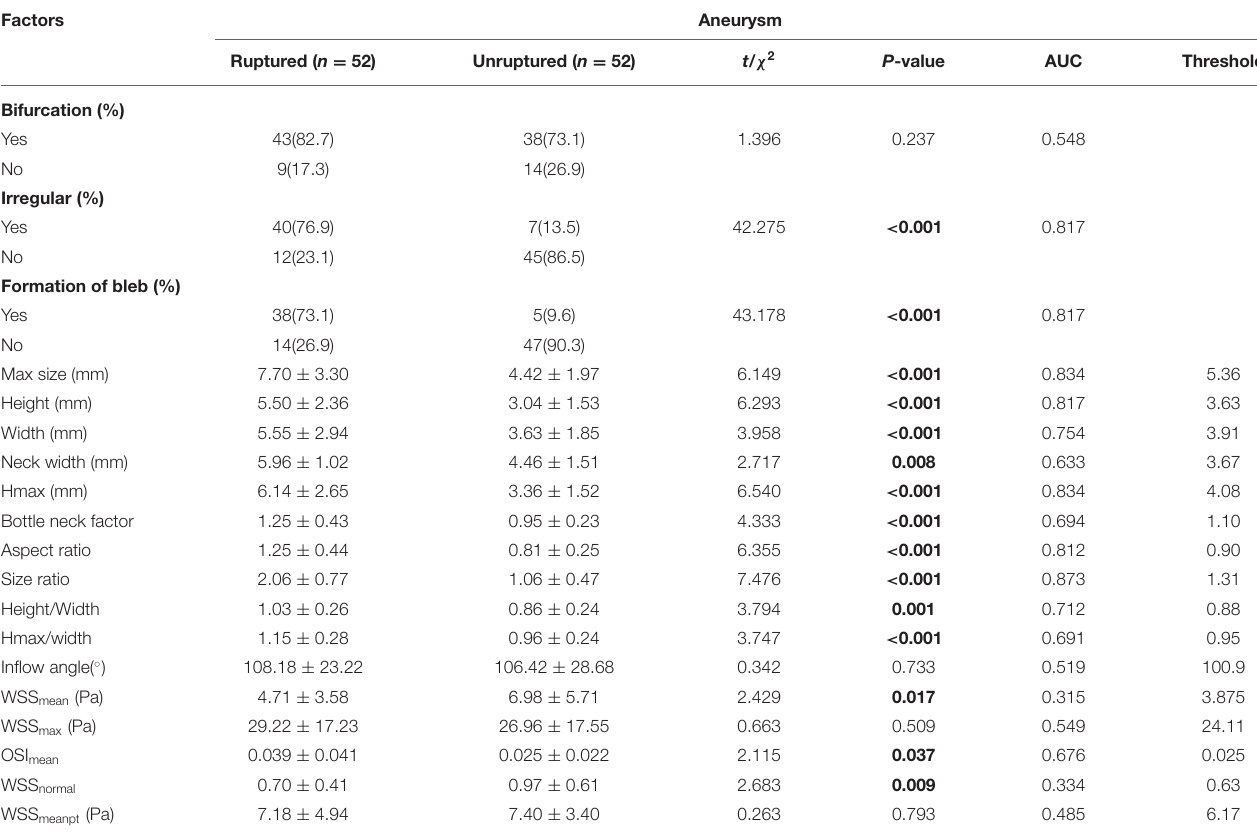
TABLE 1 | The univariate analysis of morphological and hemodynamic characteristics associated with rupture of the aneurysm. Factors Aneurysm Ruptured ( n = 52) Unruptured ( n = 52) t / χ 2 P -value AUC Threshold